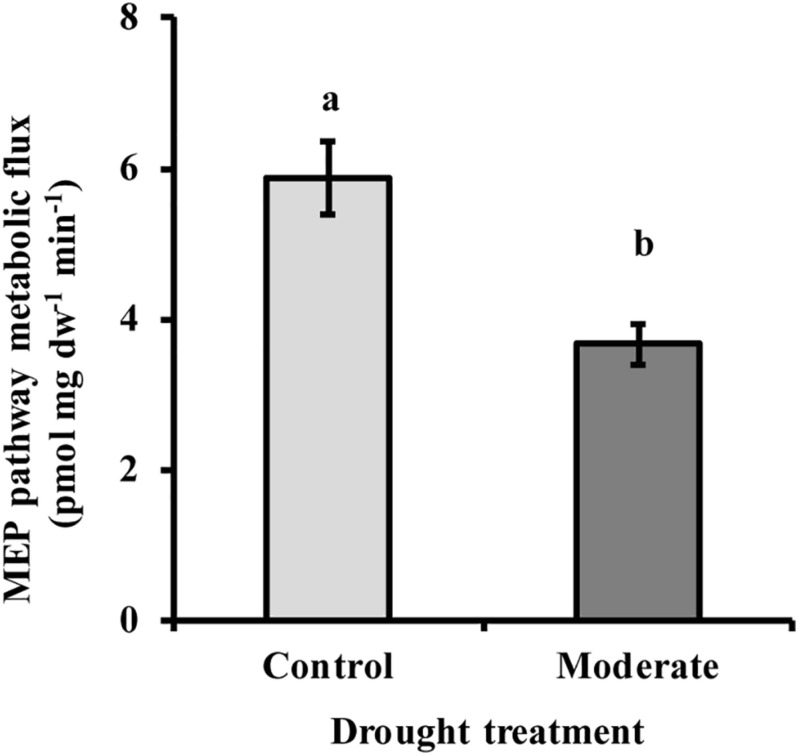
Drought decreased MEP pathway metabolic flux under moderate stress conditions. Under severe stress metabolic flux was not detectable due to very low 13C incorporation. Flux was calculated as described in the text. Data shown are means of three biological replicate ± SE. Different letters indicate significant differences at P < 0.05.